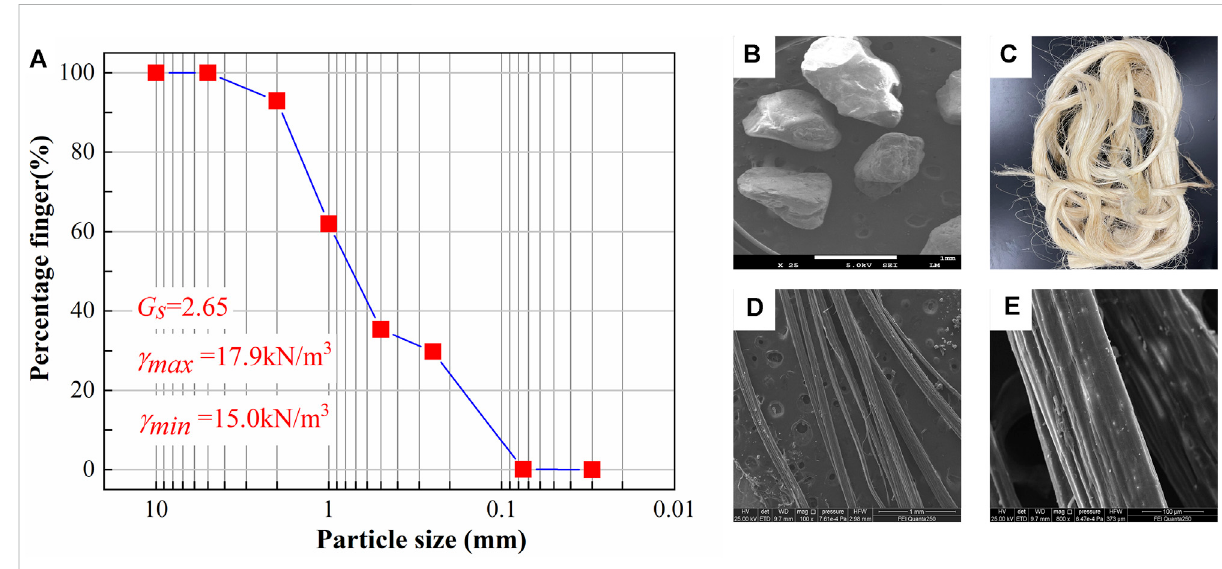
FIGURE 1 Standard sand: (A) particle size distribution; (B) microgram of sand. Sisal fi bers: (C) unampli fi ed; (D) magni fi ed for 100 times; (E) magni fi ed for 800 times.